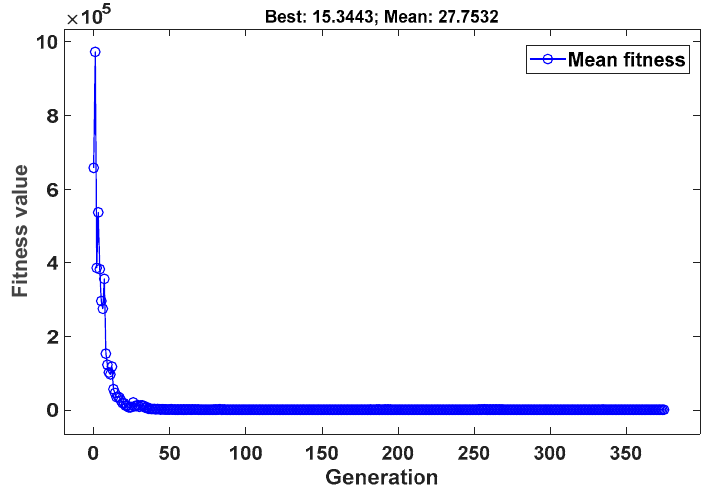
Figure 6. GA optimization process.